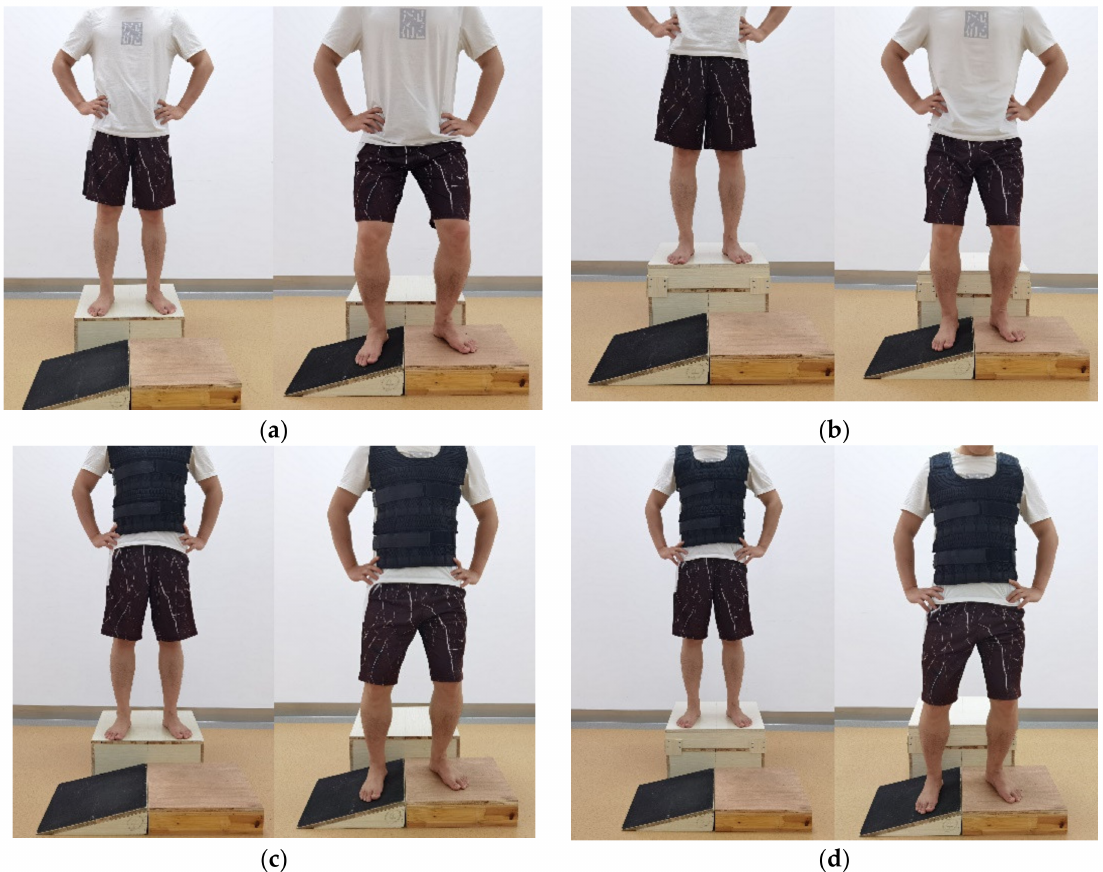
Figure 2. The different landing conditions. ( a ) load 100% and 10 cm heights; ( b ) load 100% and 20 cm heights; ( c ) load 110% and 10 cm heights; ( d ) load 110% and 20 cm